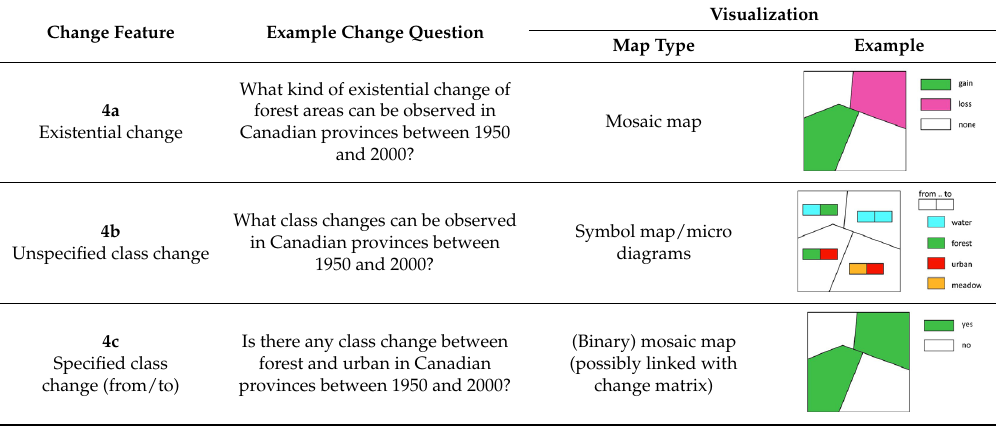
Table 4. Visualization of “What” output clauses (compare classification in Table 1). Change